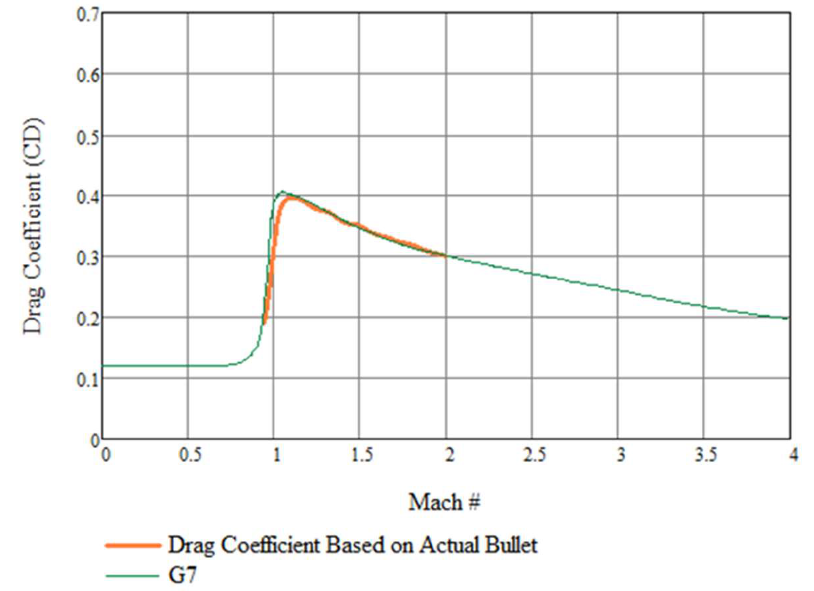
Figure 3. G7 shape Drag Coefficient versus Mach number [4]. Best fit equations for the speed of sound and density at altitude were created (Figure 4) and added to a master spreadsheet (see Supplementary Material) [5].